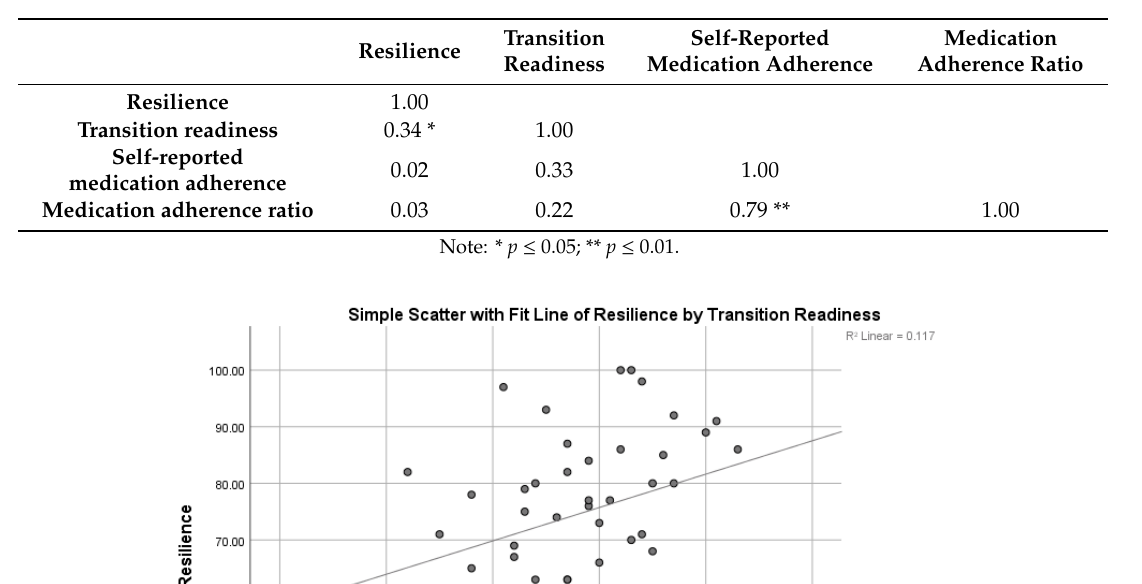
Table 2. Correlation matrix for resilience, transition readiness, and medication adherence across pediatric chronic illness populations.